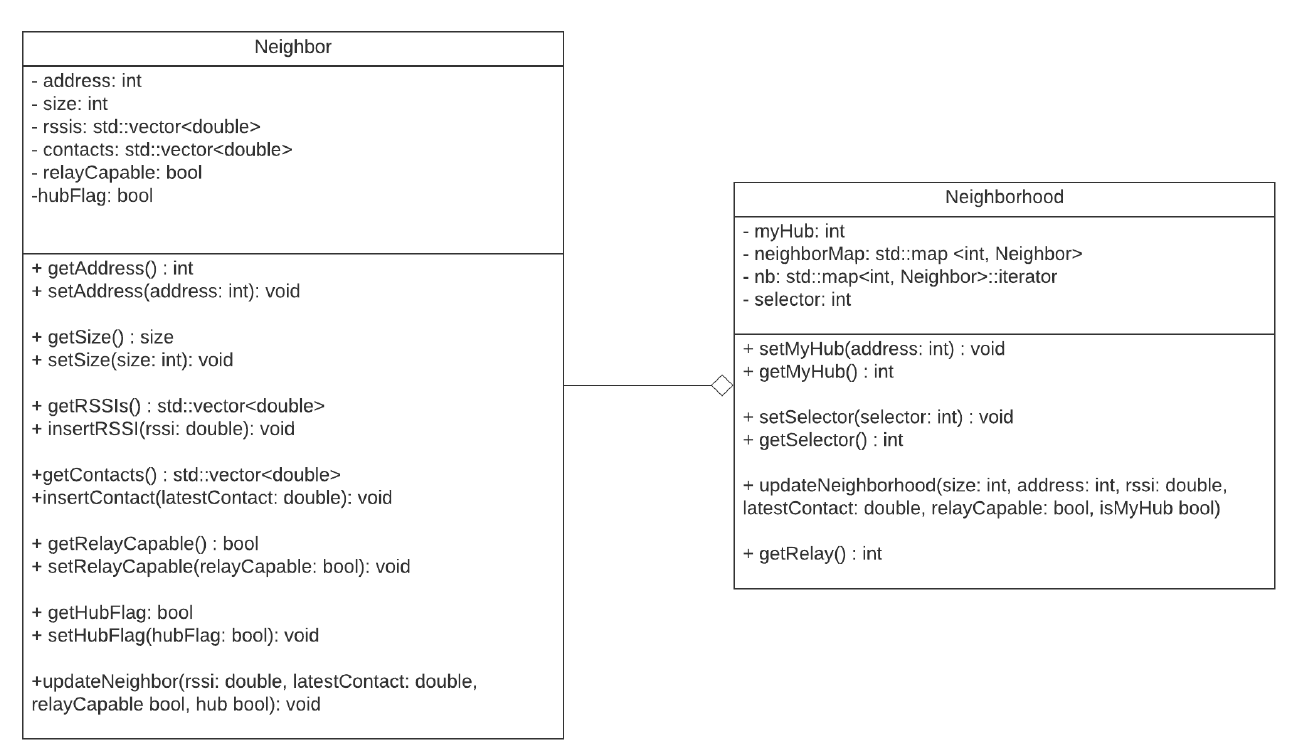
Figure 3. Class diagram for the IEEE 802.15.6 MAC module implemented in the BNS